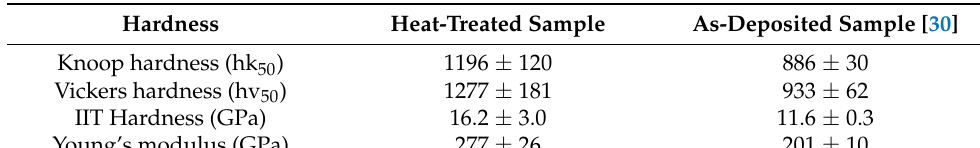
Table 4. Comparison of the mechanical properties of samples in the as-deposited and optimized heat-treated conditions.